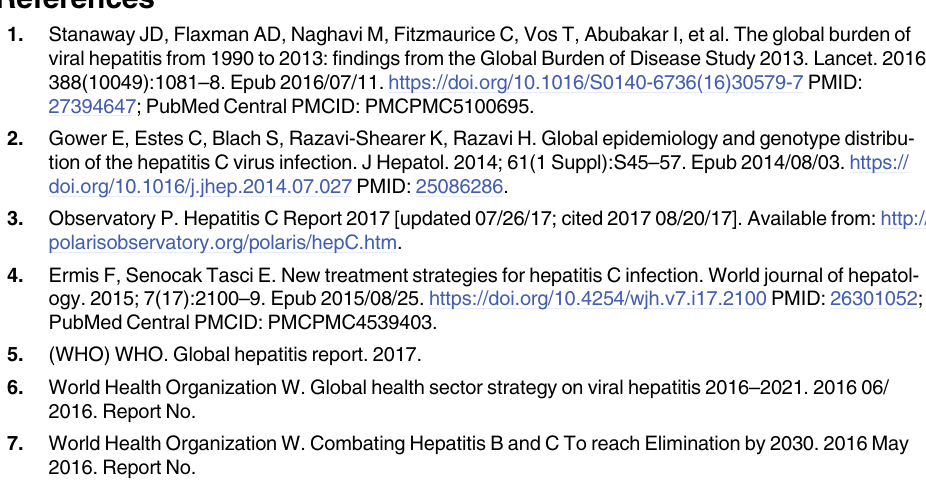
S1 Table. Model parameters and references. S2 Table. HCV treatment delivery costs and visits based on Indian treatment guidelines and India-specific prices, translated to 2017 USD. � Extensive liver tests (ie, albumin, total